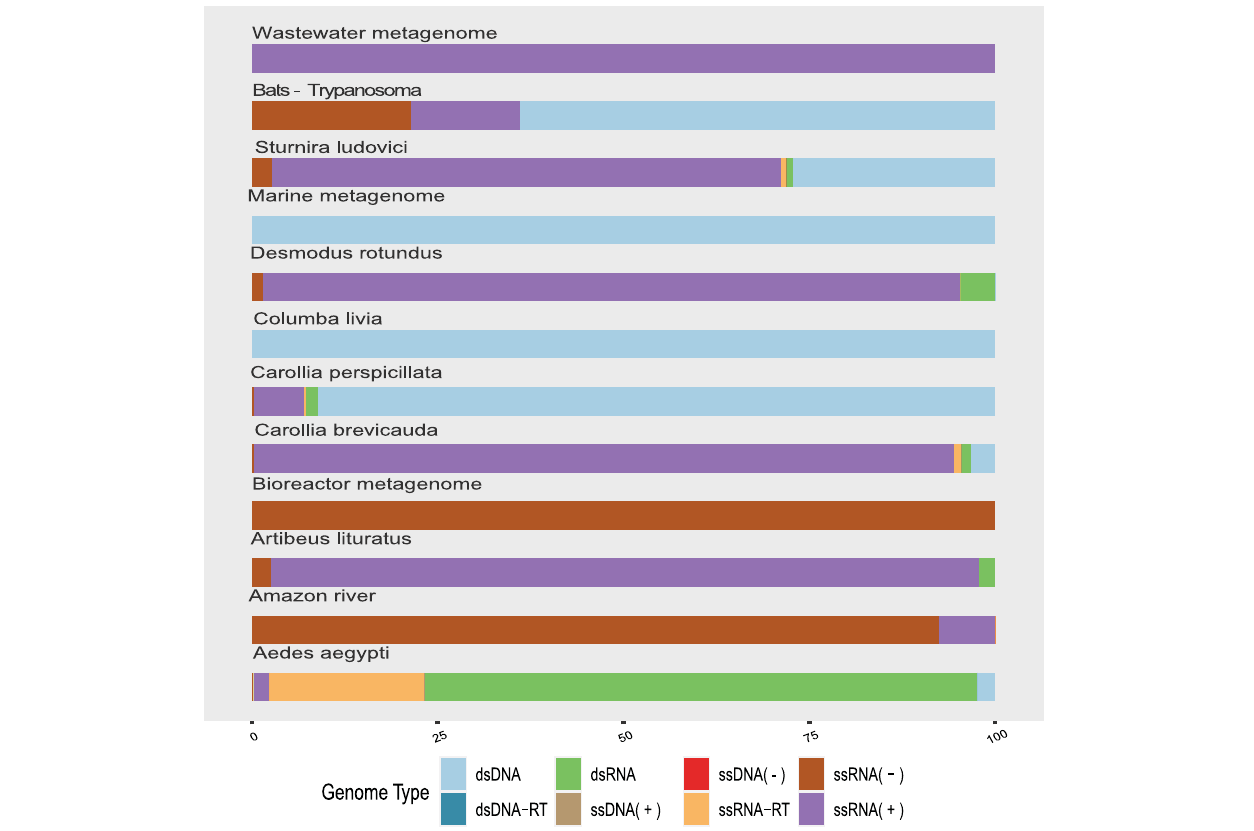
Frontiers in Genetics |